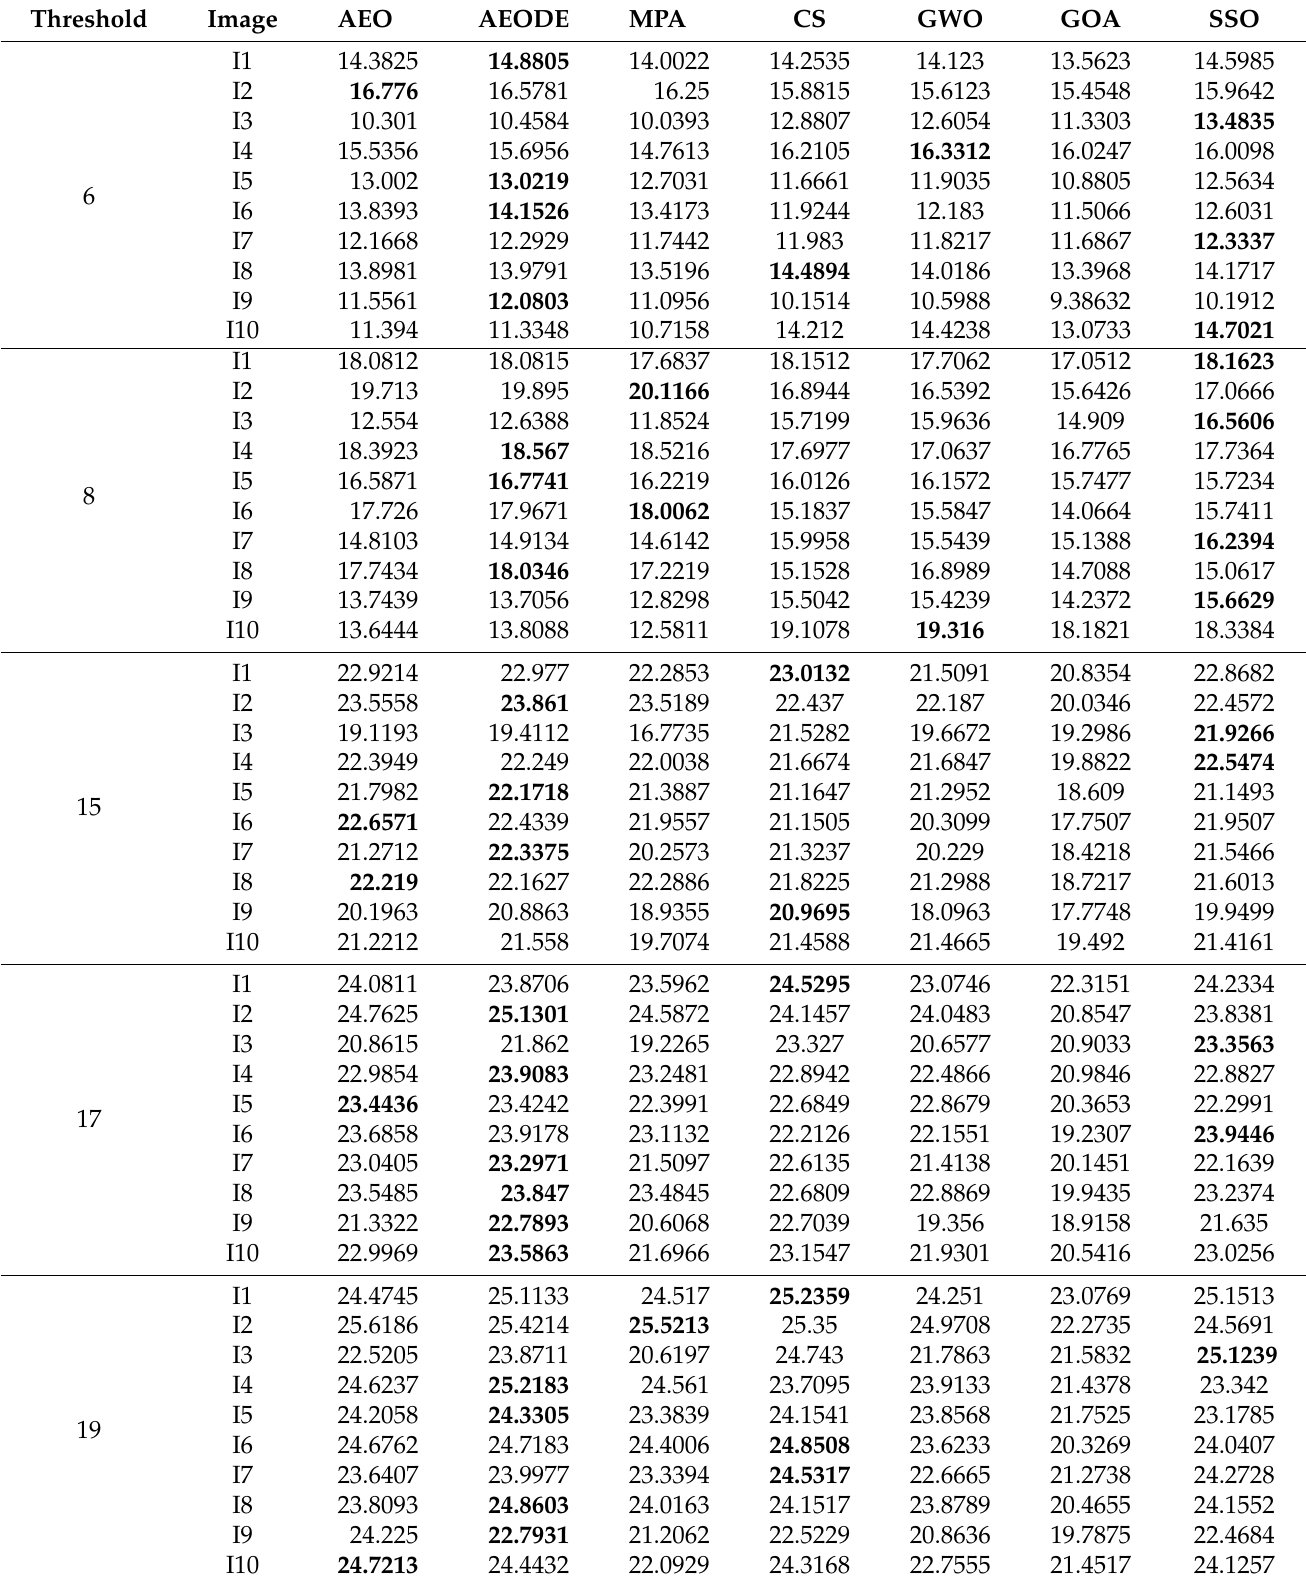
Table 2. PSNR results for all algorithms (bold means the best